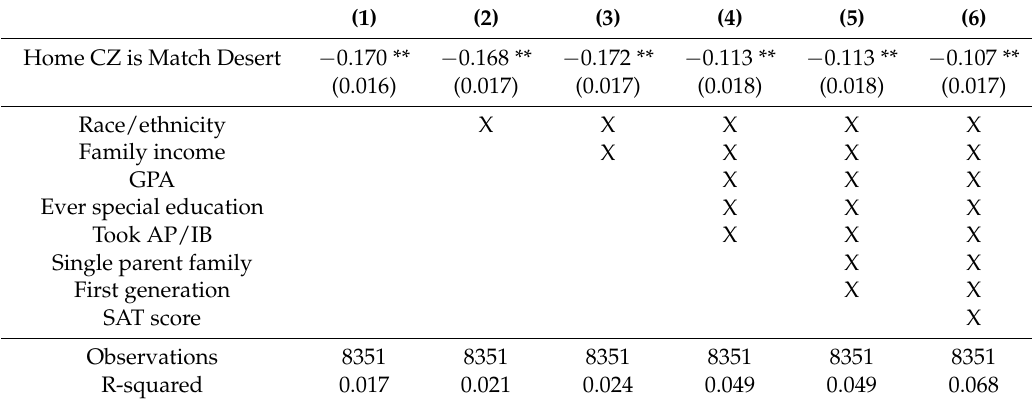
Table 7. Relationship between living in match desert and applying to a strict academic-match college.